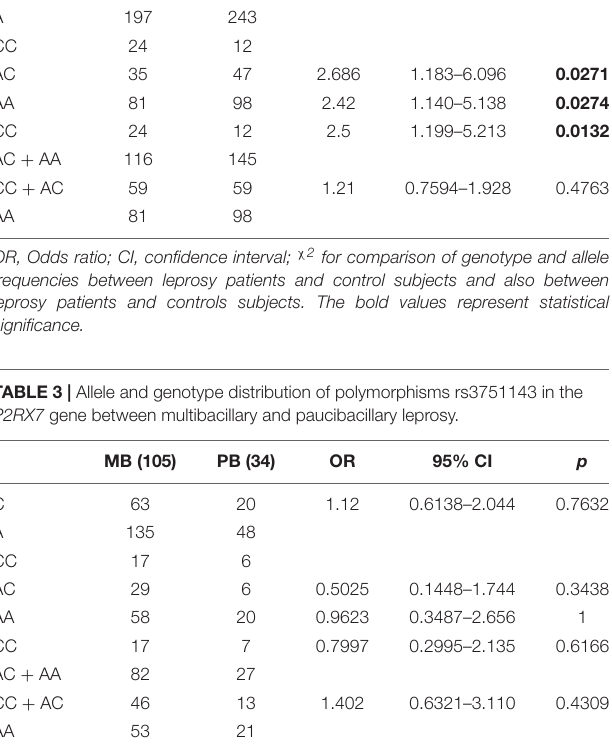
TABLE 2 | Allele and genotype distribution of polymorphisms rs3751143 in the P2RX7 gene in patients with leprosy and controls. Patients (140)